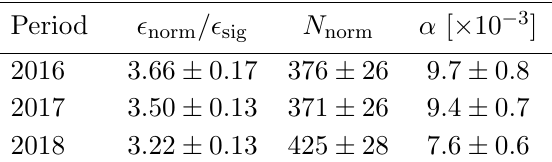
Table 1 . E(cid:14)ciency ratios between the normalisation and signal modes and the single-event sensitiv- ity, (cid:11) , for the nominal (cid:4) 0 are statistical